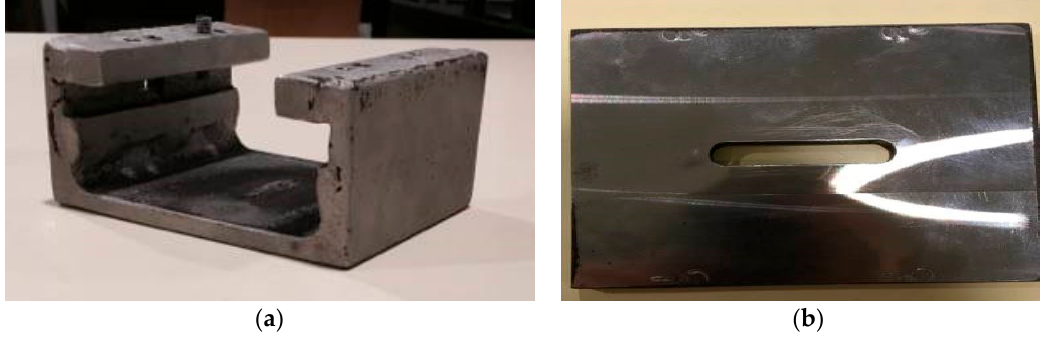
Figure 2. Clamp system: ( a ) main structure; ( b ) slotted plate.